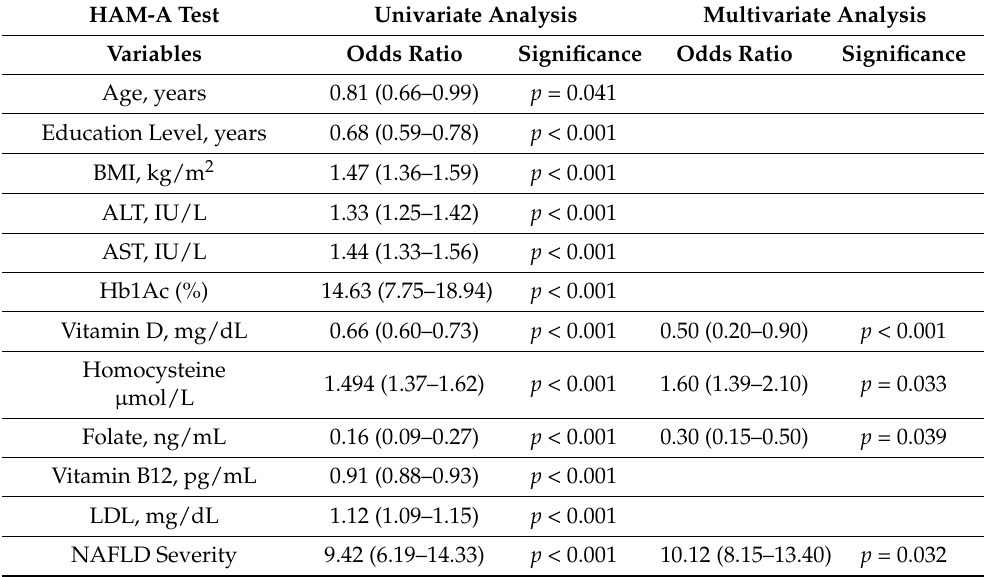
Table 7. Factors associated with worse HAM-A test results in terms of Odds Ratio and its 95% C.I. Variables are initially studied univariately and then multivariately by choosing the model with the lowest